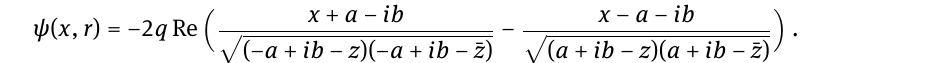
having two pairs of simple poles for which the "intensities" differ only by signs: either + q or − q . The Stokes flow function corresponding to this creative function